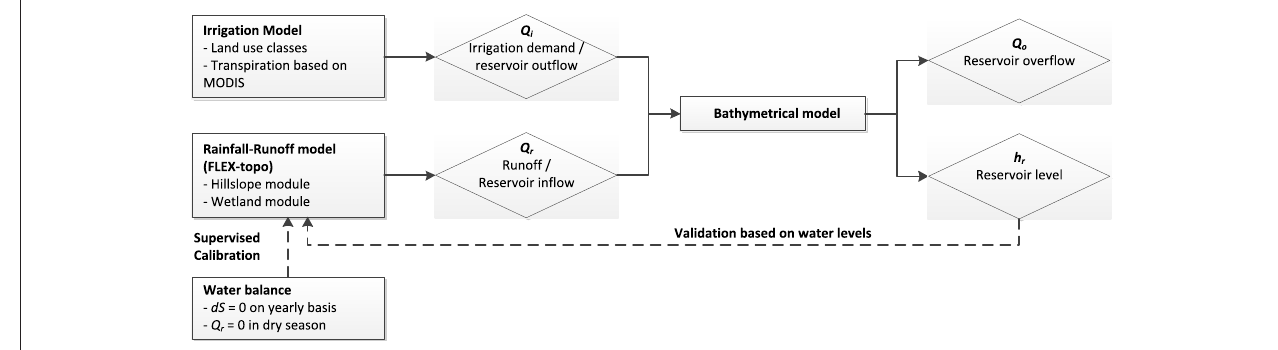
FIGURE 3 | Model structure of the rainfall-runoff and water balance models.